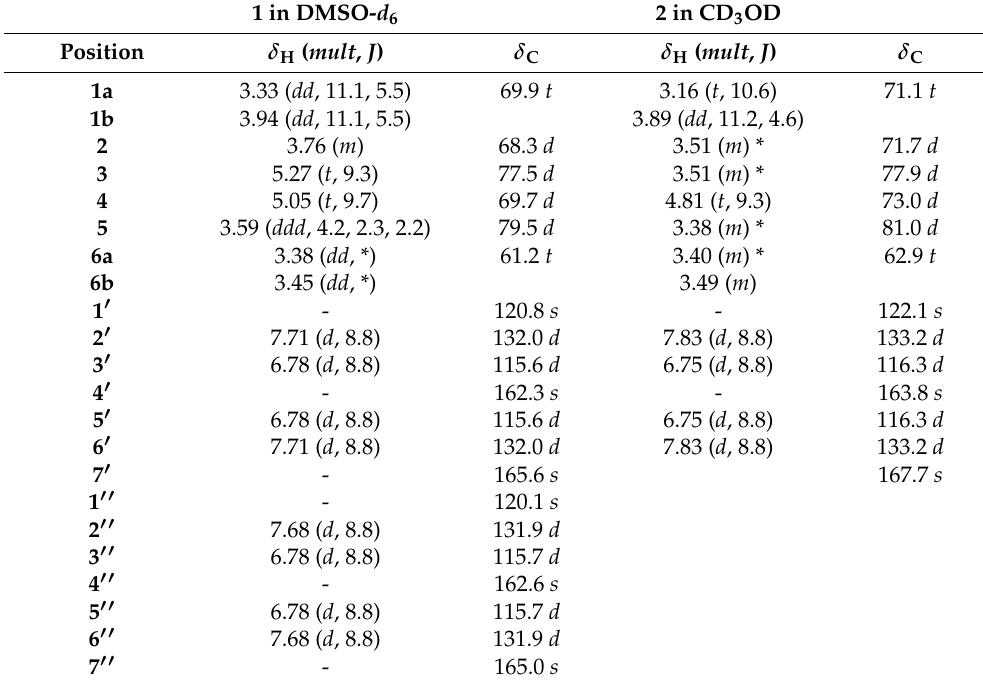
antioxidant activities [32]. Table 1. 1 H and 13 C NMR data of compounds 1 and 2 .